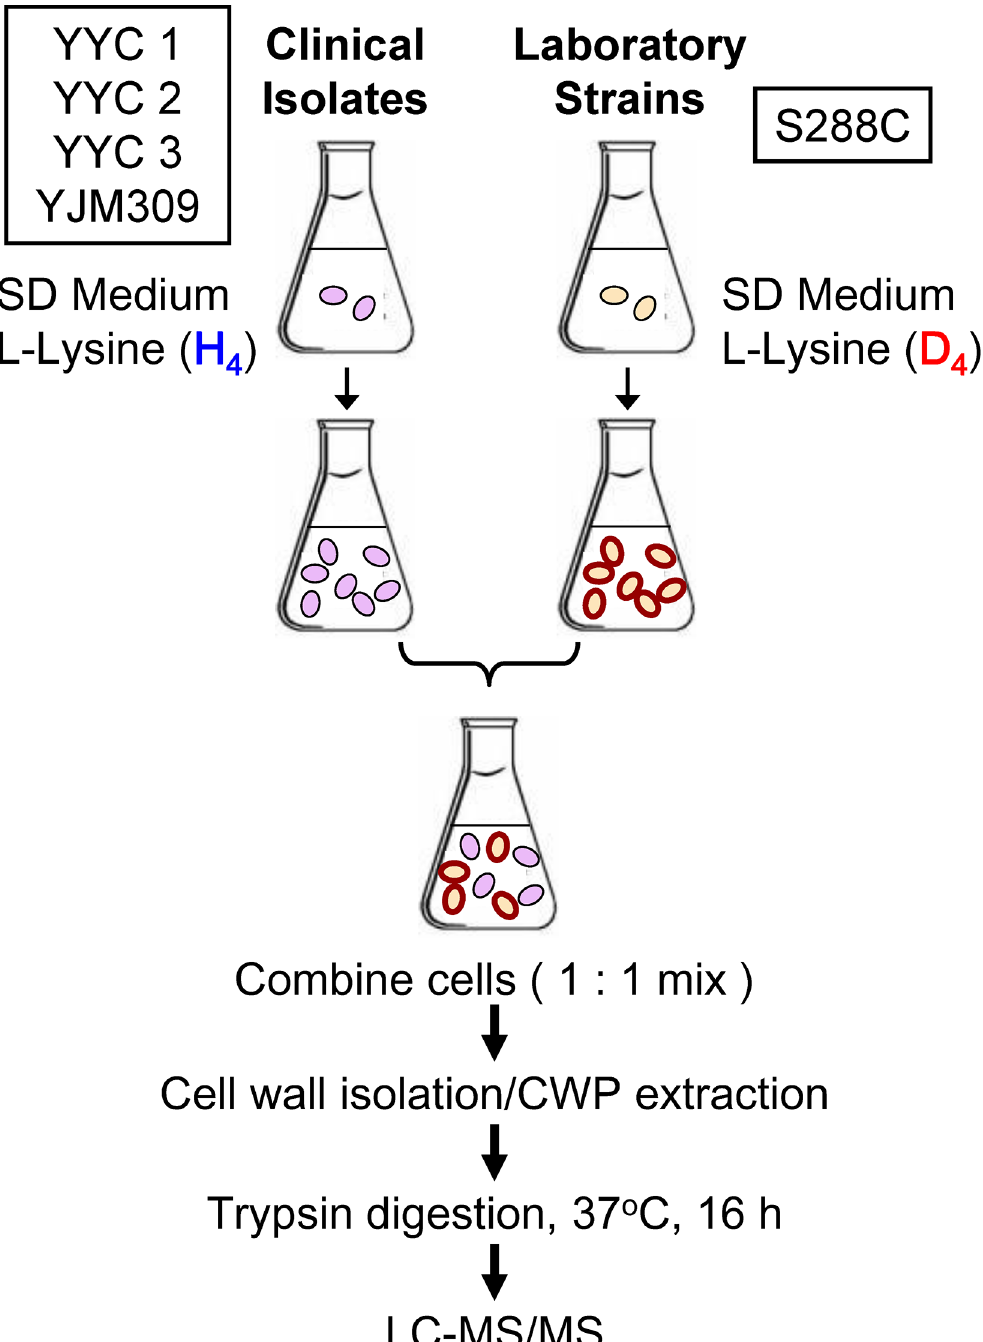
Fig 2. Strategy used to identify and quantify S . cerevisiae cell wall proteome. SILAC labeling followed by Nano-LC-MS/MS was used for relative quantitation.